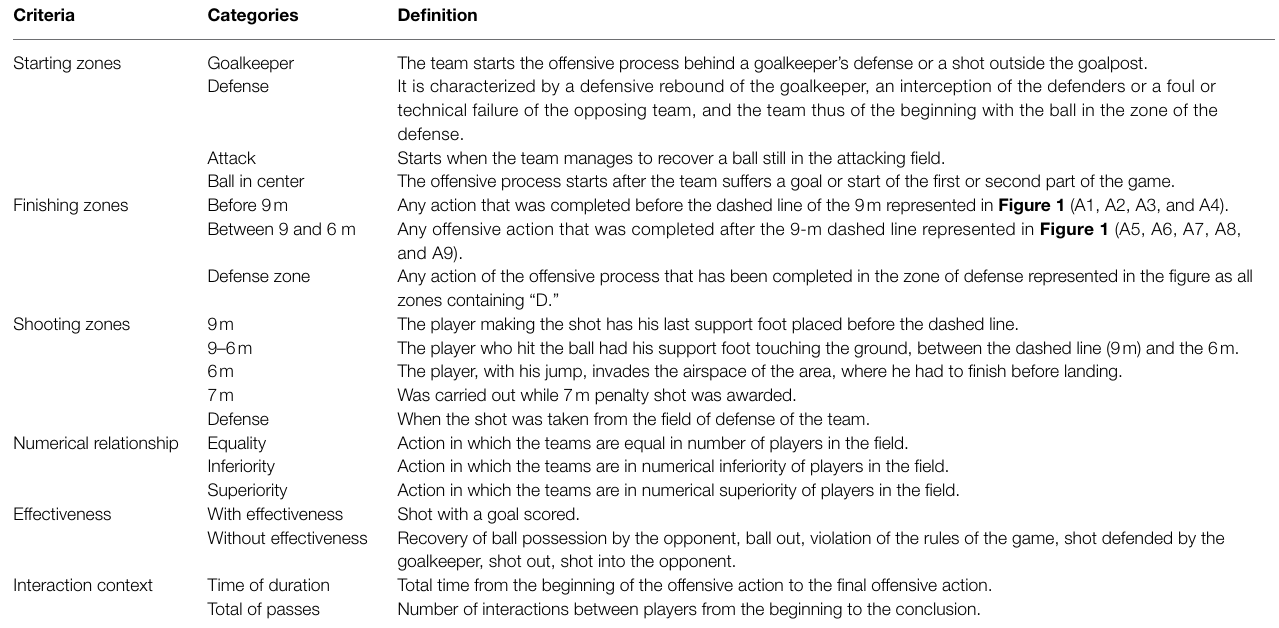
TABLE 2 | Description of variables and definitions of category used in the team match performance analysis (starting, shooting and finishing zones, effectiveness, and interaction